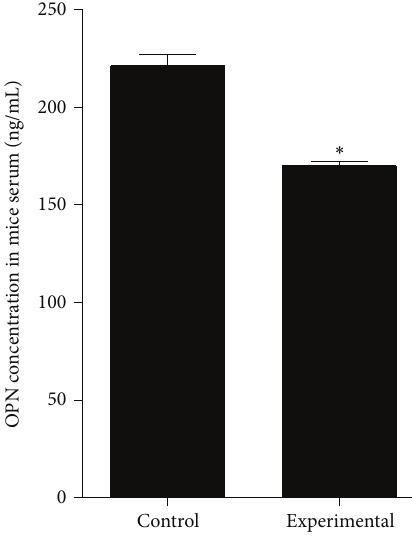
Figure 12: The concentration of OPN protein in the serum of mice derived from control and experimental-metformin treated group. Mean values express osteopontin level of nine mice belonging to the investigated group. The statistically significant decrease of OPN proteinwasnotedinserumofexperimentalanimals.Thestatistically significant difference determined in relation to the results obtained for control group was indicated with asterisks ( ∗ 𝑃 < 0.05